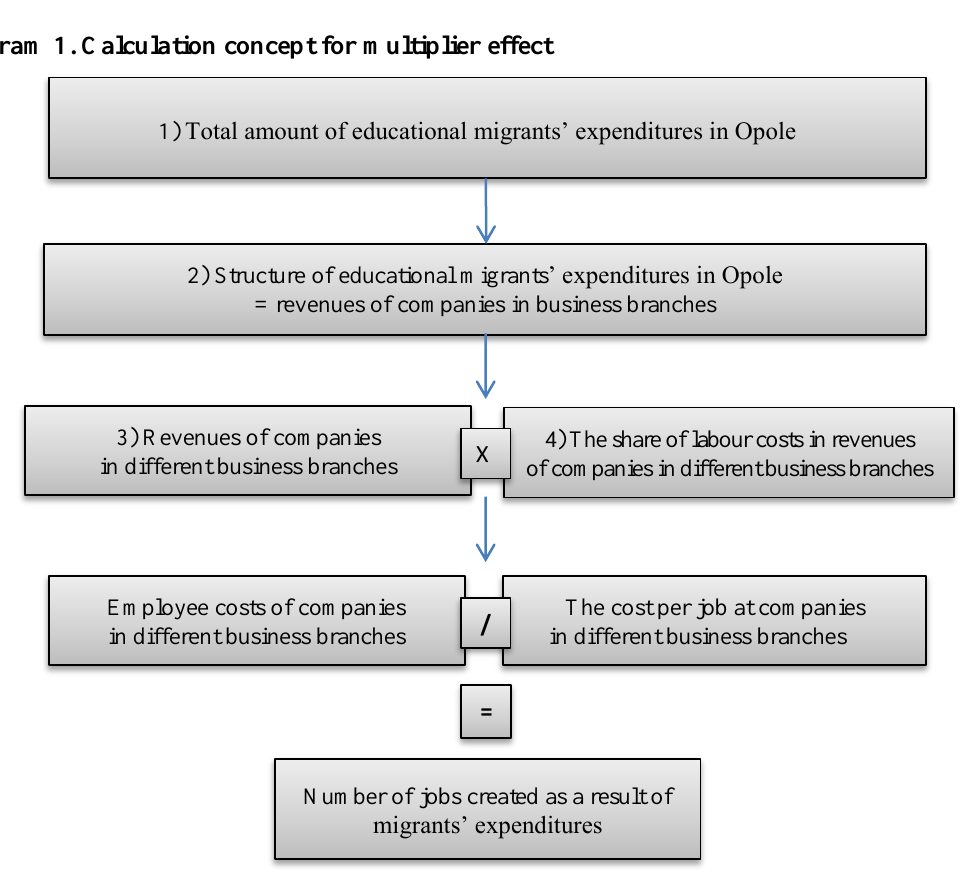
Diagram 1. Calculation concept for multiplier